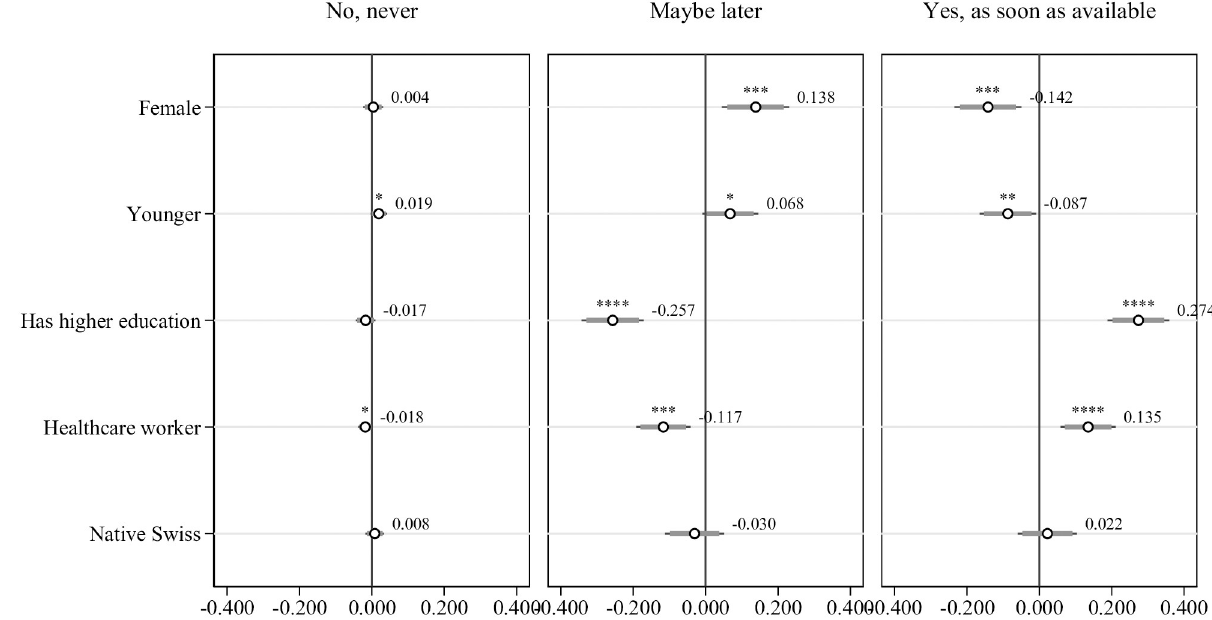
Fig 4. Multinomial probit regressions: Willingness to get vaccinated and individual characteristics, controlling for situational factors, Big-5 personality traits and preferences. Dependent variable is willingness to get vaccinated. Situational factors include belonging to COVID-19 risk group, living with someone belonging to COVID-19 risk group, having had contact with a COVID-19 infected person outside work, having been outside Switzerland, using public transport and having had a positive test result of COVID-19 in the past. Personality traits include extroversion, agreeableness, conscientiousness, stability and openness. Preferences include the level of trust in strangers, risk aversion, patience, future orientation, altruism and reciprocity and the perceived percentage of people in the region wanting to get vaccinated. All regressions include hospital and time fixed effects. Standard errors in parentheses, n = 915. � p < 0.1, �� p < 0.05, ��� p < 0.01, ���� p <